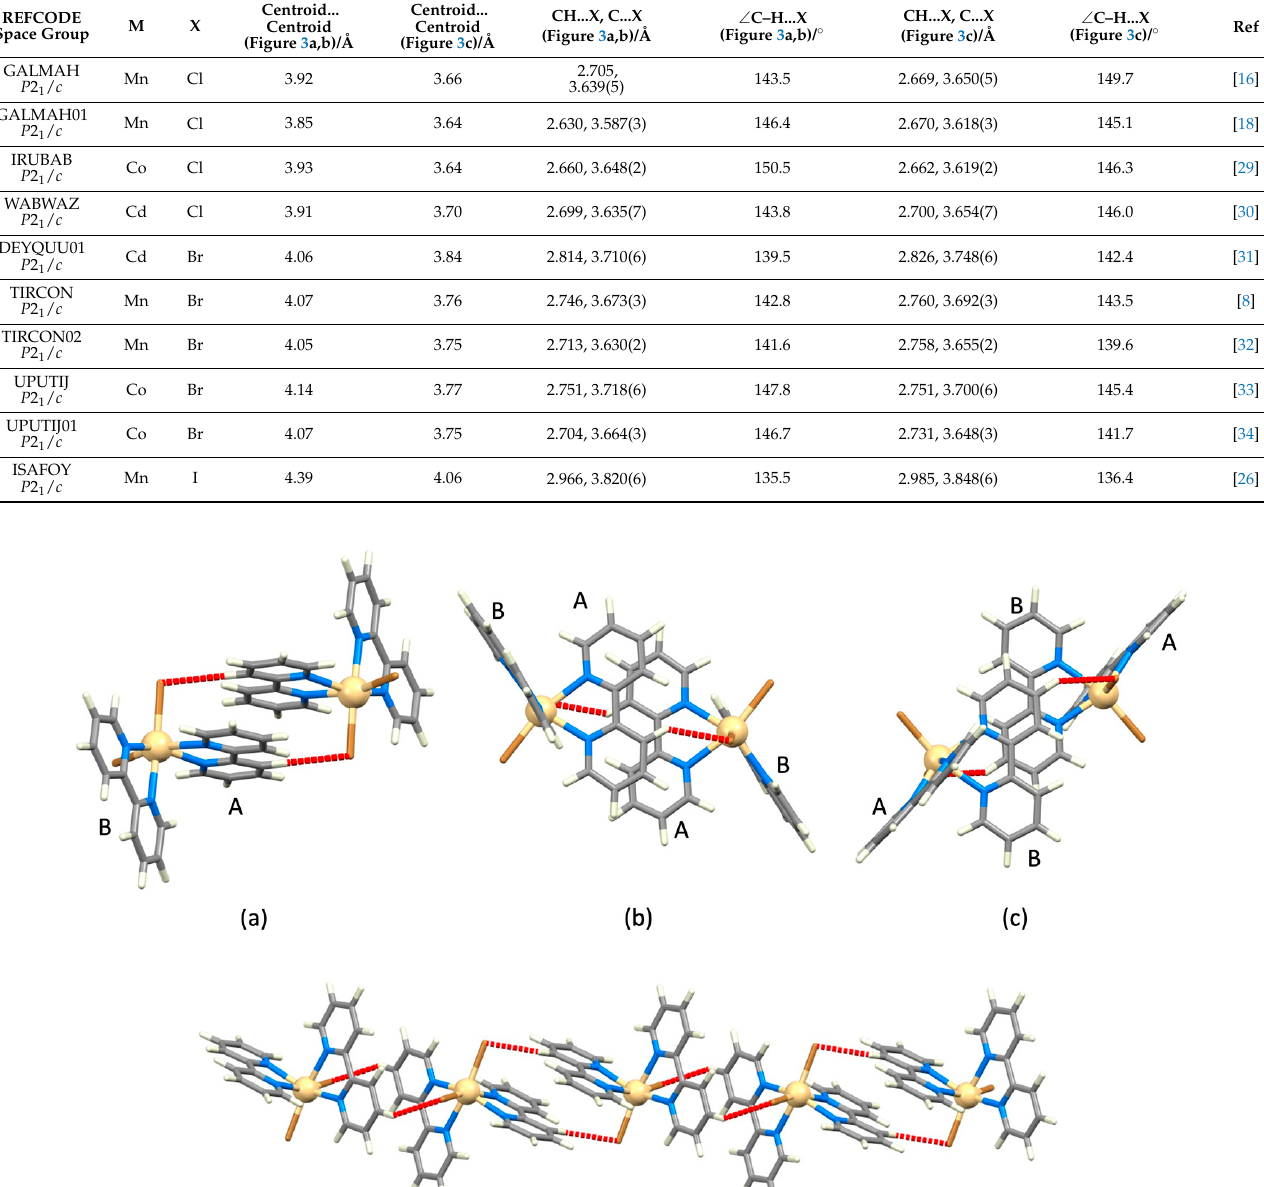
[28] Figure 4. Packing interactions in cis- [Cd(bpy) 2 I 2 ] (CSD refcode TIBLAT [27]): ( a ) π -stacking interaction with H3...I and H4...I contacts (in red), and ( b ) assembly of a 1D-chain. We noted earlier that the structure of cis -[Mn(bpy) 2 I 2 ] (CSD refcode ISAFOY [26], Table 2) exhibits non-optimal face-to-face π -stacking. It is, therefore, signi fi cant that a second polymorph (CSD refcode ISAFOY01 [14]) has been reported, and that this is structurally analogous to cis- [Cd(bpy) 2 I 2 ] (CSD refcode ABEBIV [35], a polymorph of the compound with CSD refcode TIBLAT, Figure 4). These polymorphs of cis -[Mn(bpy) 2 I 2 ] and cis- [Cd(bpy) 2 I 2 ] crystallize in the monoclinic space group C 2/ c and exhibit a packing